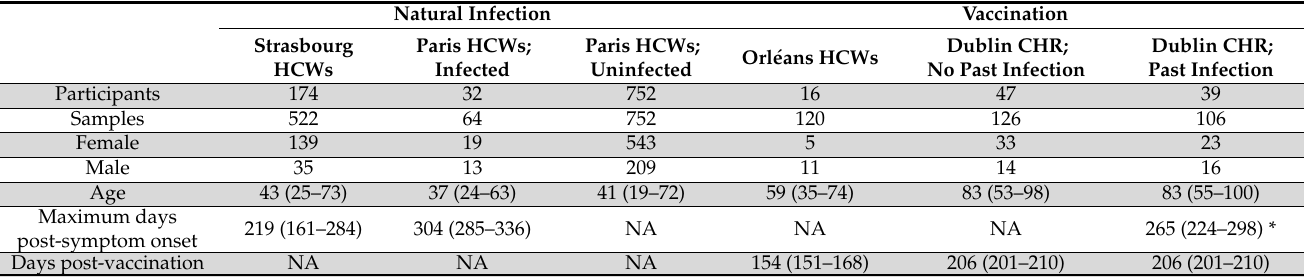
Table 1. Panels of samples included in the